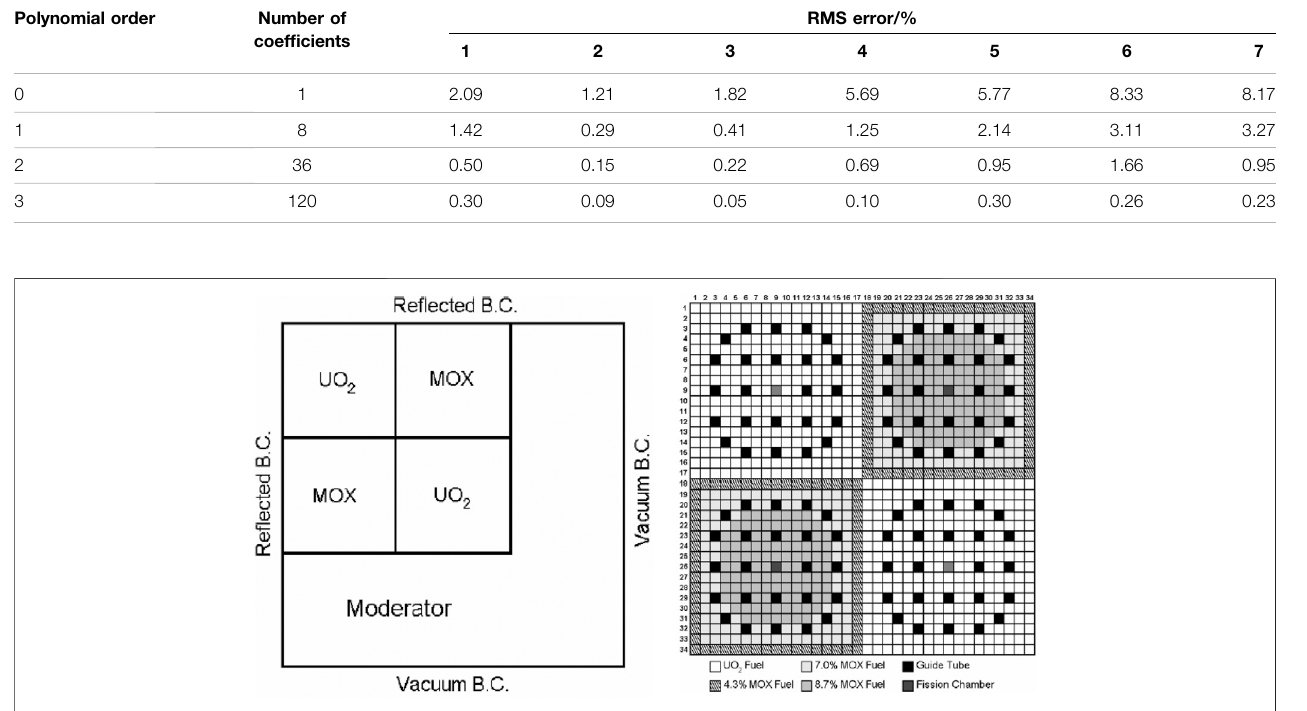
FIGURE 6 | 2D C5G7